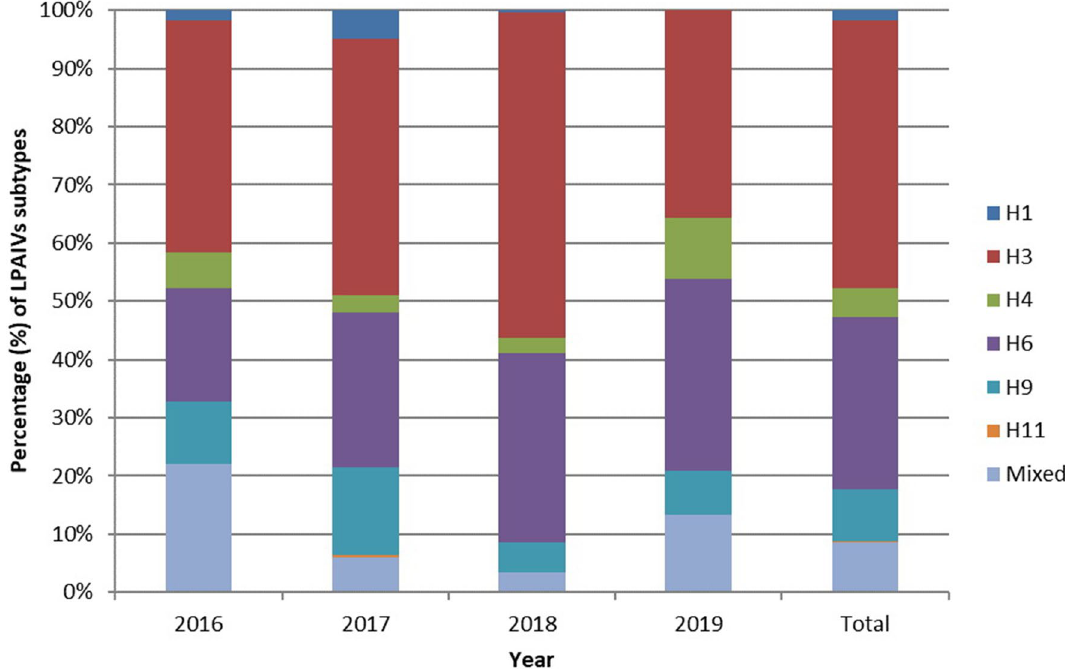
Figure 3. Percentage of the isolated HA subtypes from 2016 to 2019.